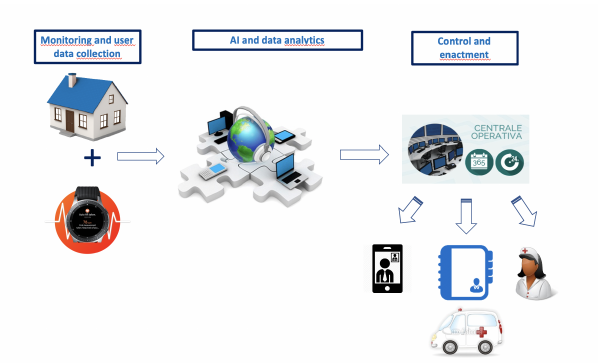
Figure 1. The Assisto eCare 4.0